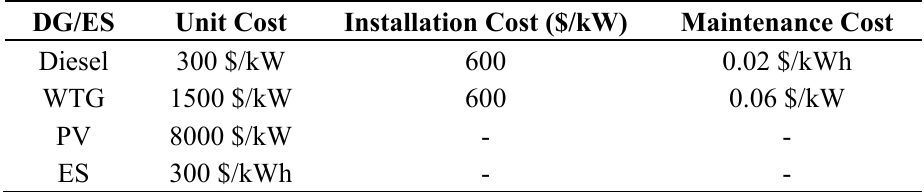
Table 4. Costs for diesel, WTG, PV, and ES units.